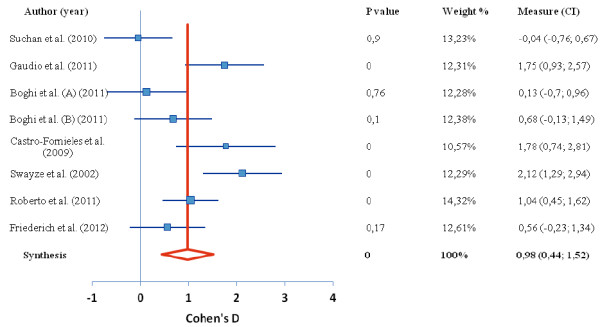
Difference in CSF volume between anorexia nervosa and control group. Forest plot depicting the difference in global cerebrospinal fluid volume between patients with AN and healthy controls. Authors of study are given on left, red line indicates median, blue boxes indicate separate studies; p value = statistical significance threshold; weight % as adjusted for study population size; CI = confidence intervals.